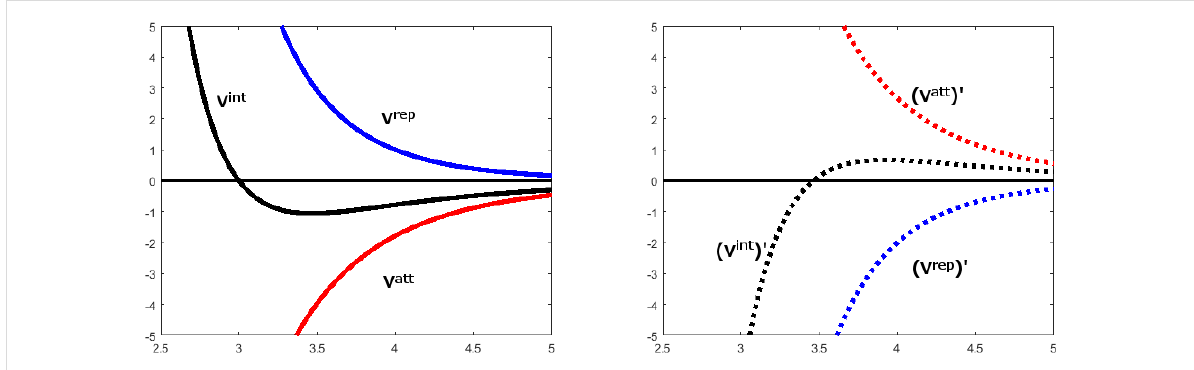
Figure 1: Left: The graphs of an interaction potential V int composed of an attractive component V att and a repulsive component V rep . Right: The corre- sponding slope